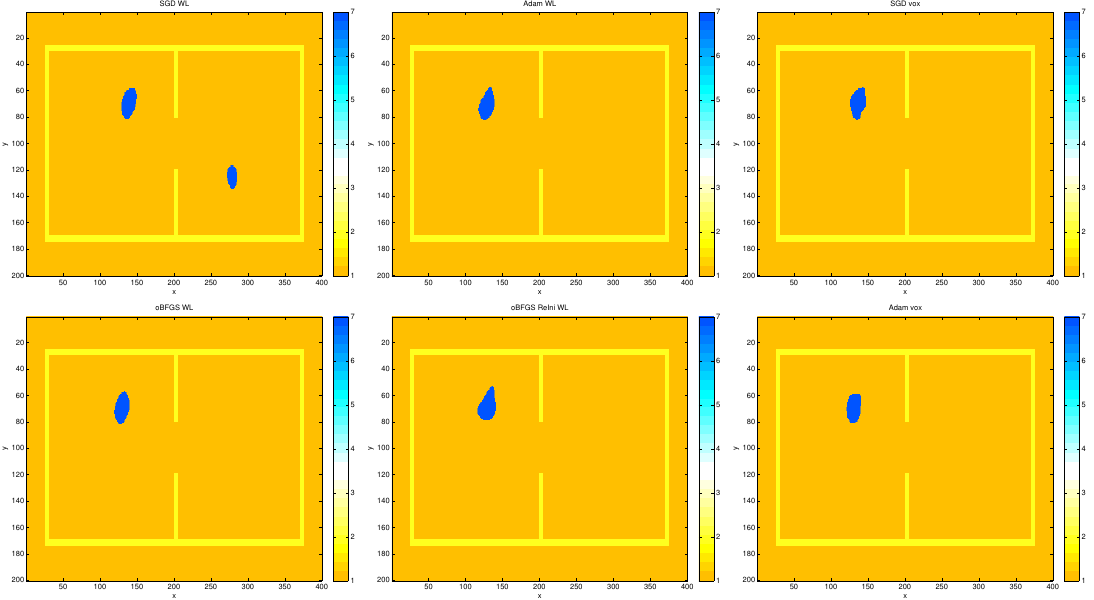
Figure 4. Final permittivity profiles achieved. Top row from left to right: SGD WL, Adam WL and SGD vox. Bottom row from left to right: oBFGS WL, oBFGS ReIni WL, Adam vox. The previous comparisons are made assuming the same fixed line search scheme. This scheme does not enforce a continuous reduction of the cost but requires, at each iteration, that the number